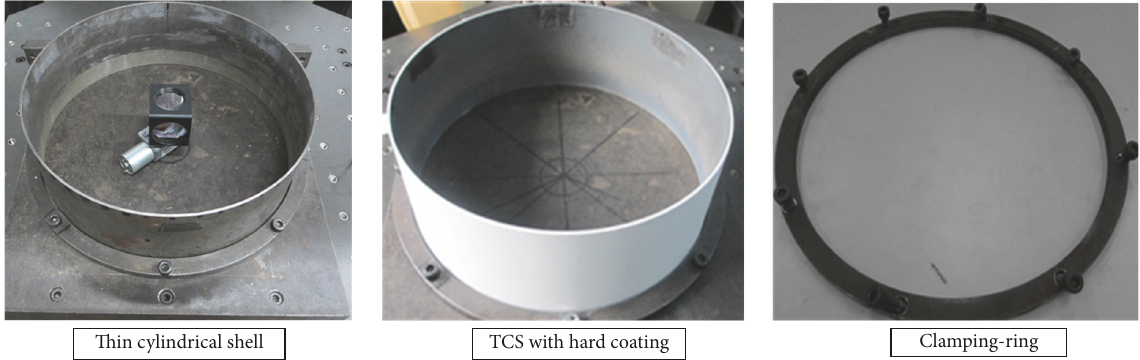
Figure 1: TCS coated with and without hard coating and its clamping-ring used in cantilever boundary condition.